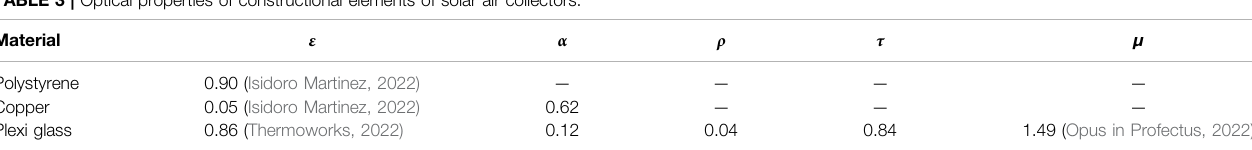
TABLE 3 | Optical properties of constructional elements of solar air collectors. Material